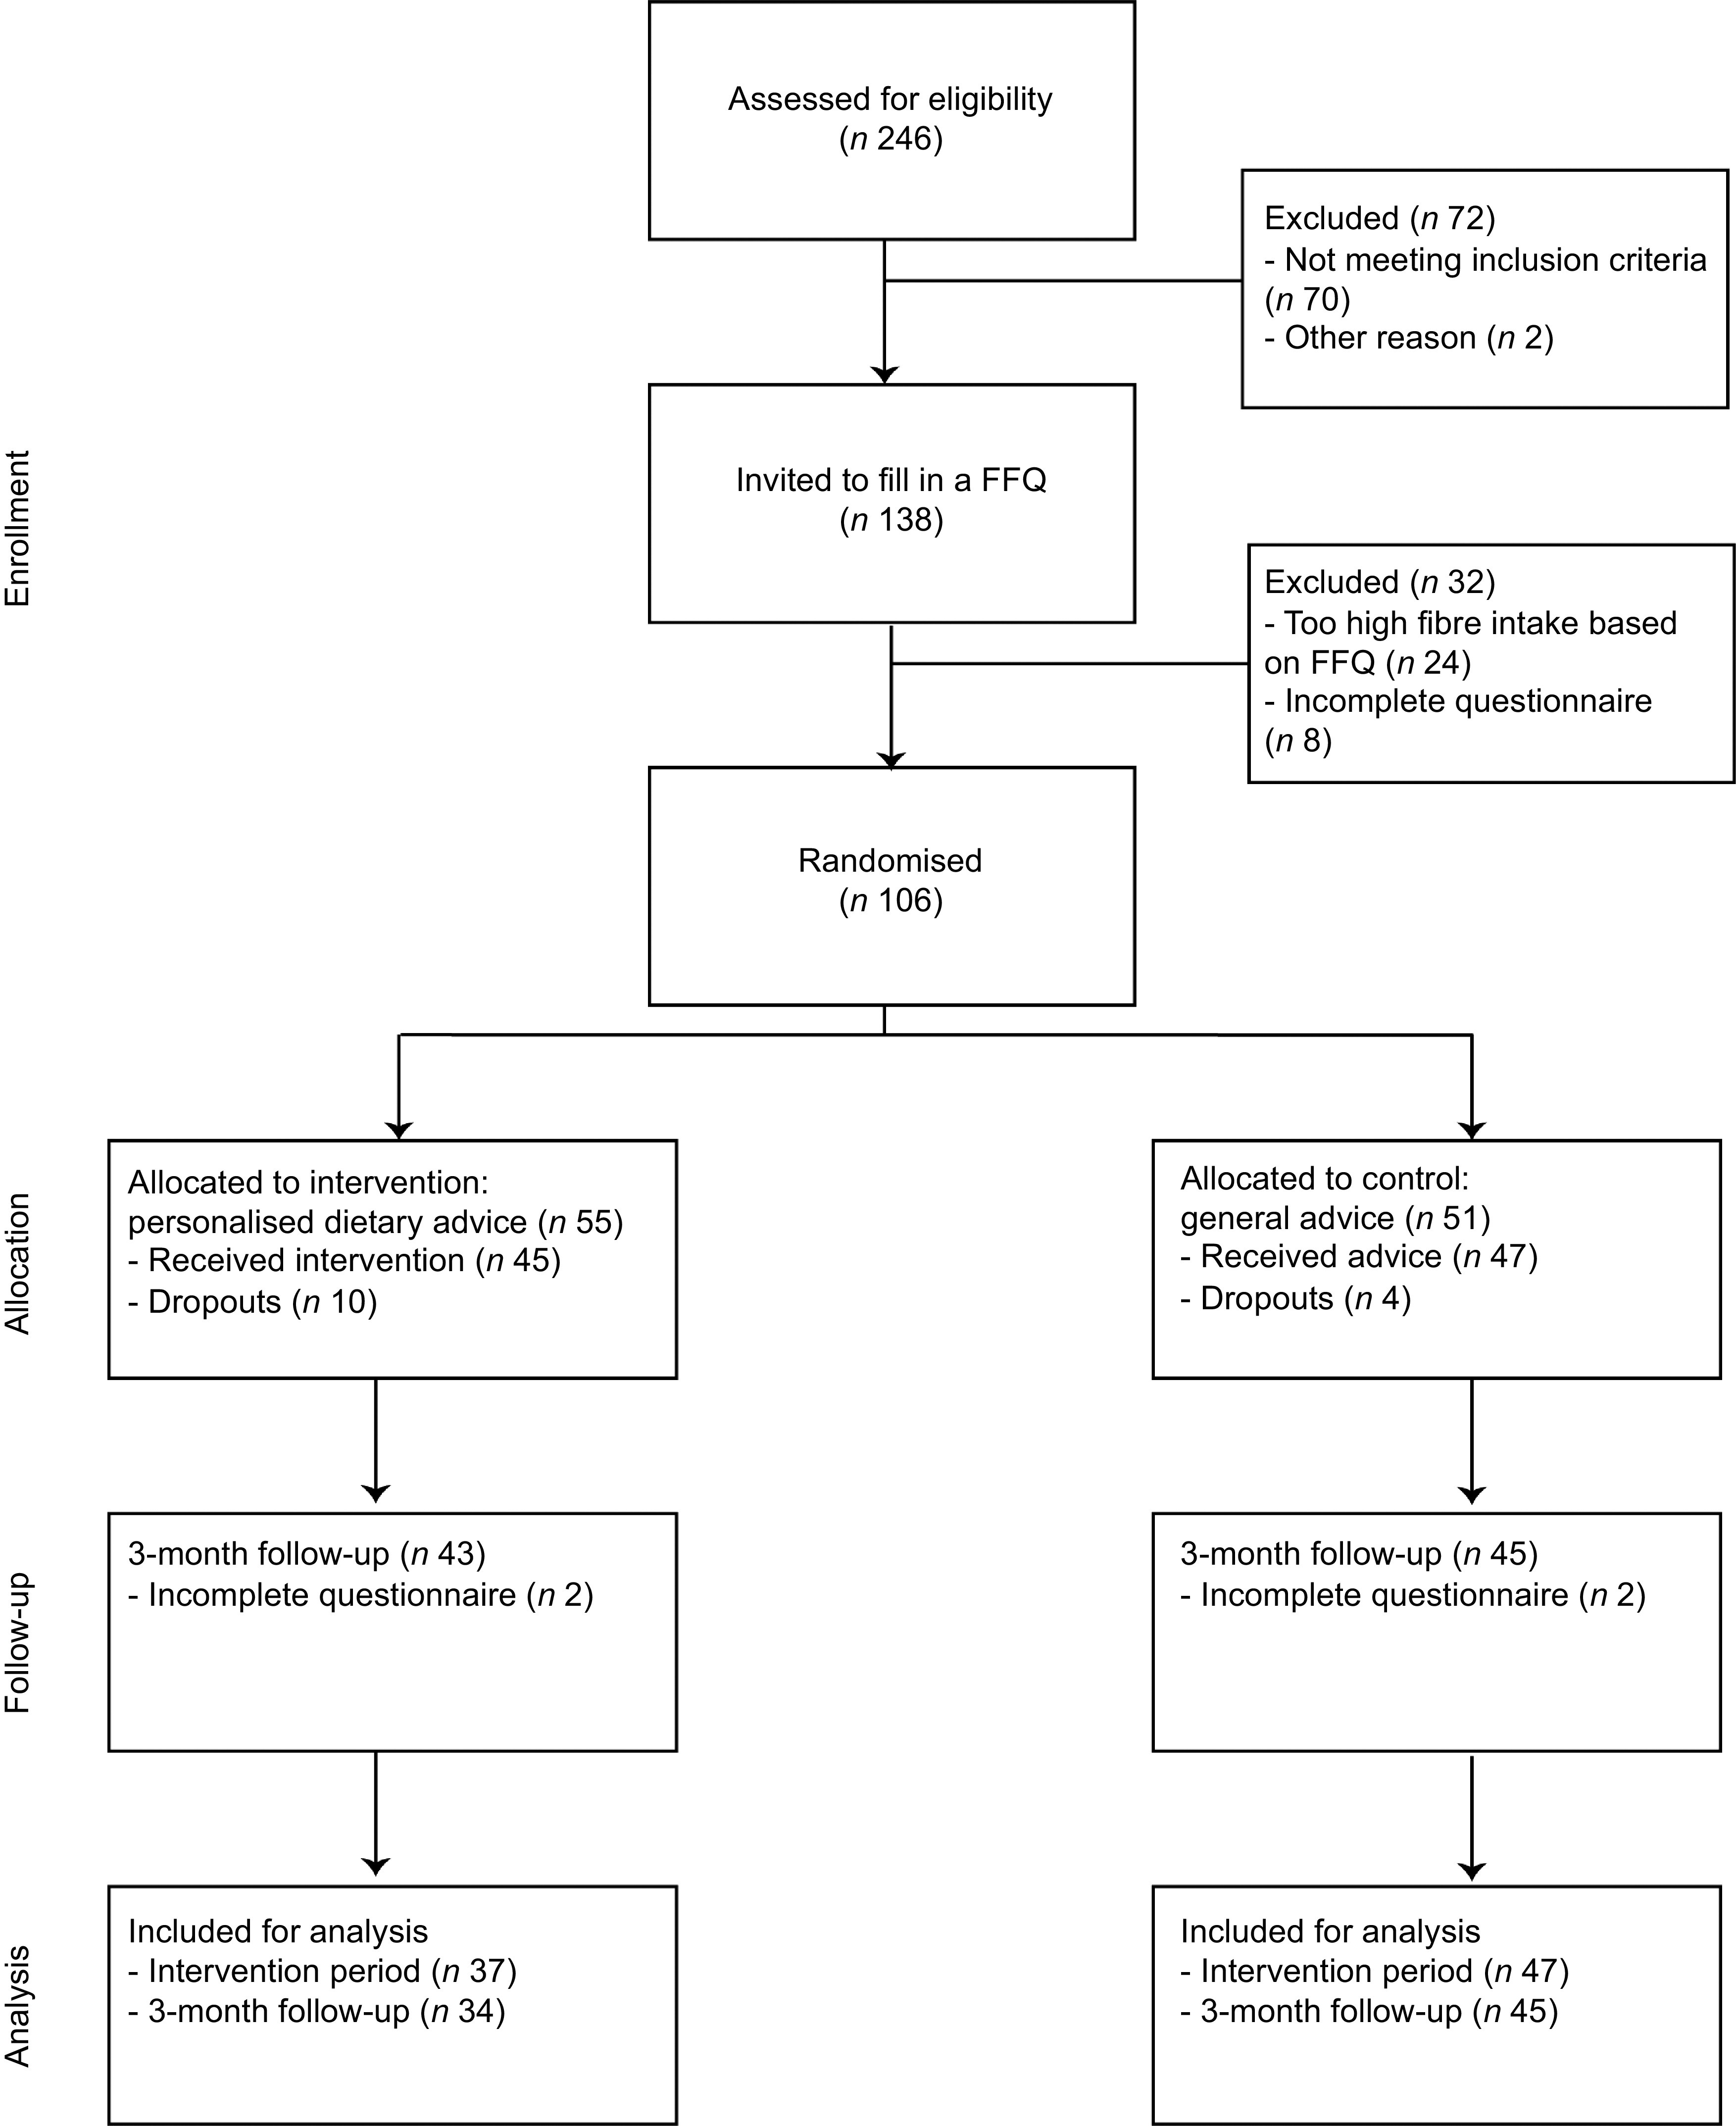
Study recruitment and flow chart